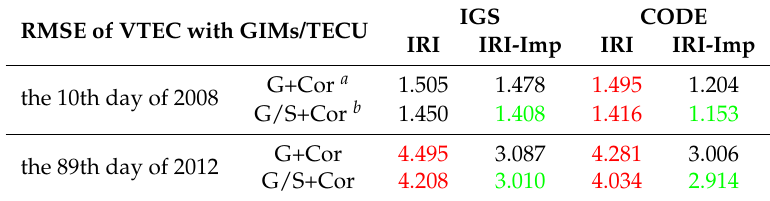
Table 4. Sensitivity of different background fields to occultation observation data on GIM models from different data centers (red text, significantly improved items; green text, items with best results). RMSE of VTEC with GIMs/TECU